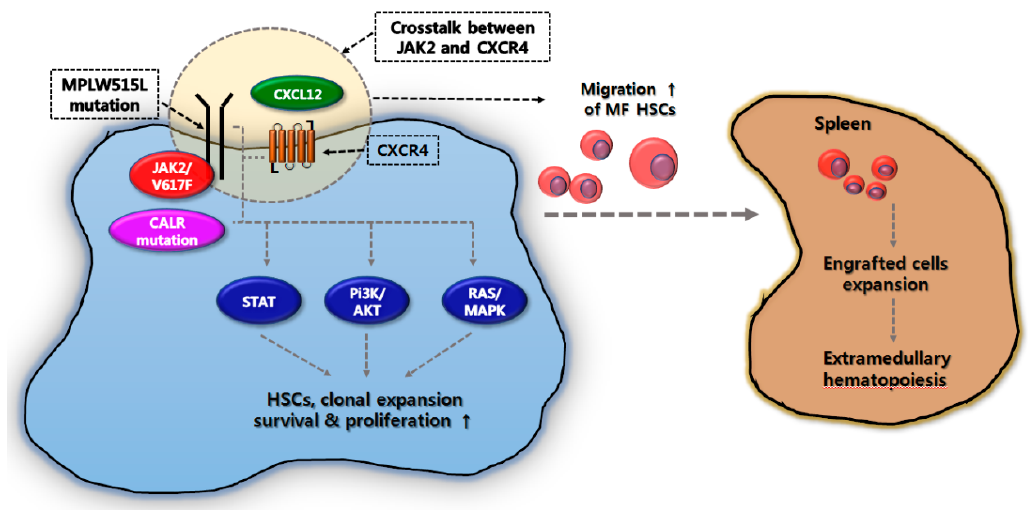
Figure 1. Splenic extramedullary hematopoiesis in myelofibrosis. Cooperation between JAK2 signaling and C-X-C motif chemokine ligand 12 (CXCL12)/C-X-C chemokine receptor type 4 (CXCR4) axis activates downstream signal transducer and activator of transcription (STAT), phosphatidylinositol-3-kinase (PI3K/AKT), and RAS/MAPK pathways, leading to clonal expansion of hematopoietic stem cells (HSCs) and hematopoietic progenitor cells (HPCs) in the bone marrow. Moreover, it encourages the transfer and engraftment of the HSCs and HPCs to the spleen.